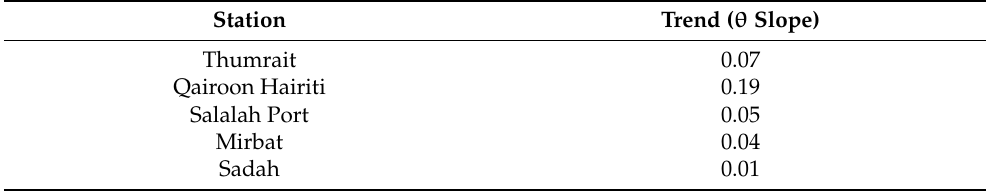
Table 3. Annual trend of air temperature from observation stations during